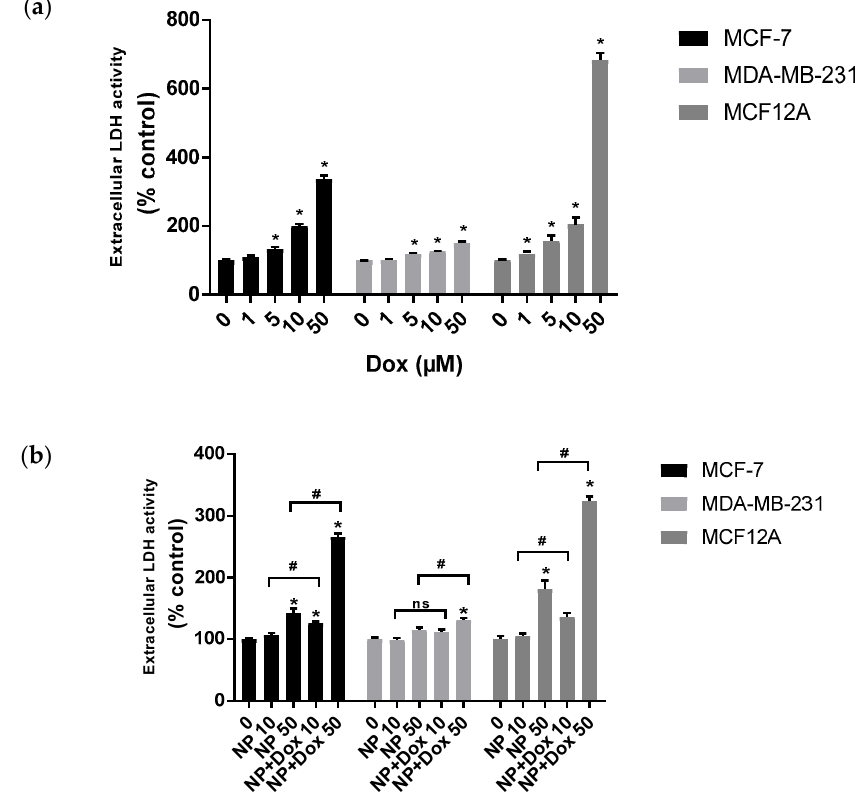
Figure 9. Cell viability after exposure for 24 h to ( a ) free doxorubicin ( µ M) and to ( b ) unloaded nanoparticles (NP) and nanoparticles loaded with DOX (NP + DOX; µ M), for all cellular lines. Shown are arithmetic means ± SEM ( n = 8). ( a ) * significantly di ff erent from control ( p < 0.05) (Student’s t test). ( b ) * significantly di ff erent from control; # significantly di ff erent from each other ( p < 0.05; ANOVA + Student-Neuman–Keuls test); ns not significant ( p < 0.05; ANOVA + Student-Neuman–Keuls test)